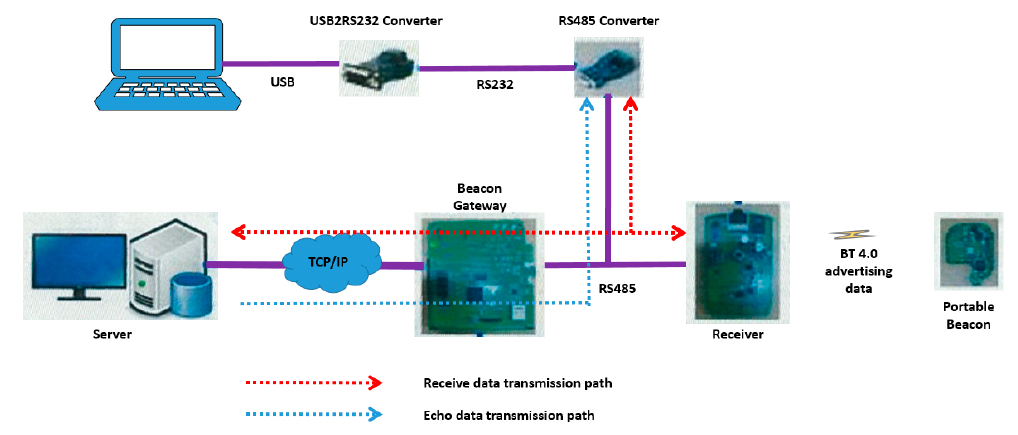
Figure 17. Concept of configuration for hardware communication.